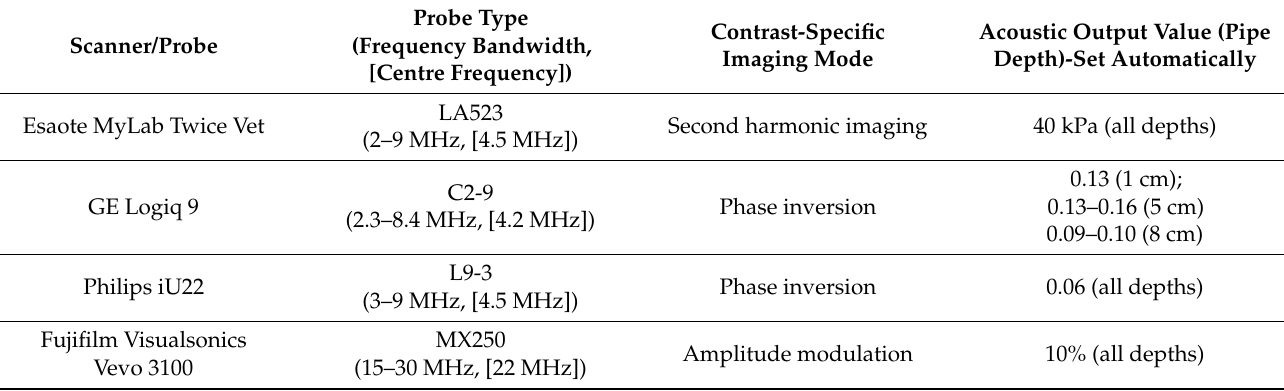
Table 3. Scanner and Transducer combinations used in the study and CSIM employed. Each scanner was setup in default contrast